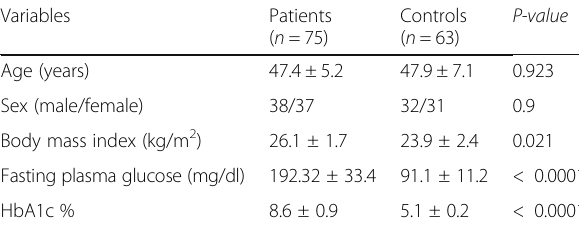
Table 1 The clinical and biological characteristics of the participants